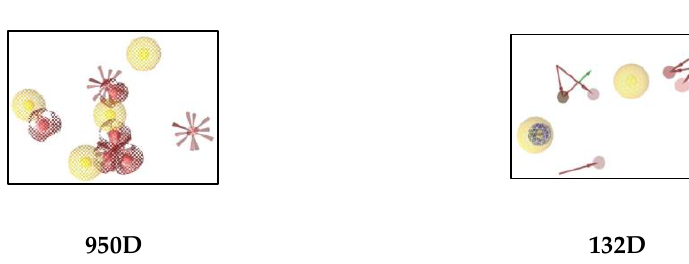
Figure 14. Six unique pharmacophore features: hydrophobic interactions (H), yellow; hydrogen bond acceptor (HBA), red; hydrogen bond donor (HBD), green; aromatic (AR) interaction; negative ionisable area (NI) interaction, brick red; positive ionisable area (PI) interaction, purple.